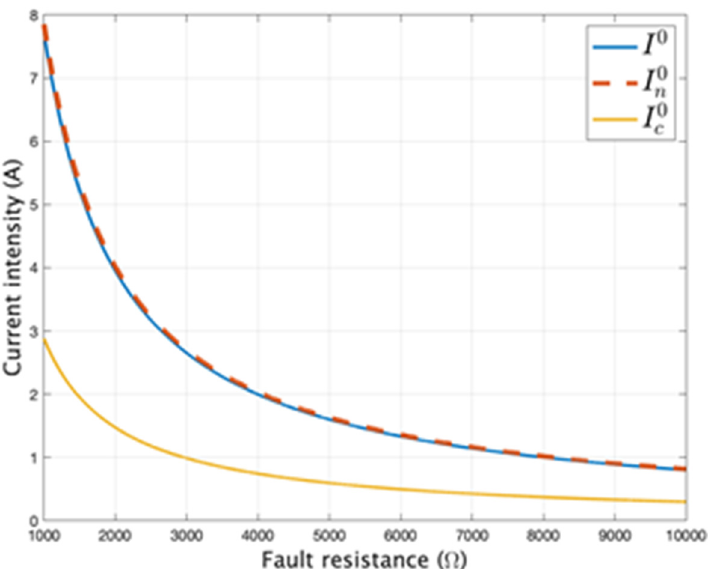
Figure 7. Current 𝐼 (cid:2868) , 𝐼 (cid:3041)(cid:2868) ,𝐼 (cid:3030)(cid:2868) as functions of fault resistance 𝑅 (cid:3047) ∈ [1000, 10,000 Ω ], tan δ = 0 ( δ = 0), 𝑈 (cid:3032)(cid:2868) = 0 .